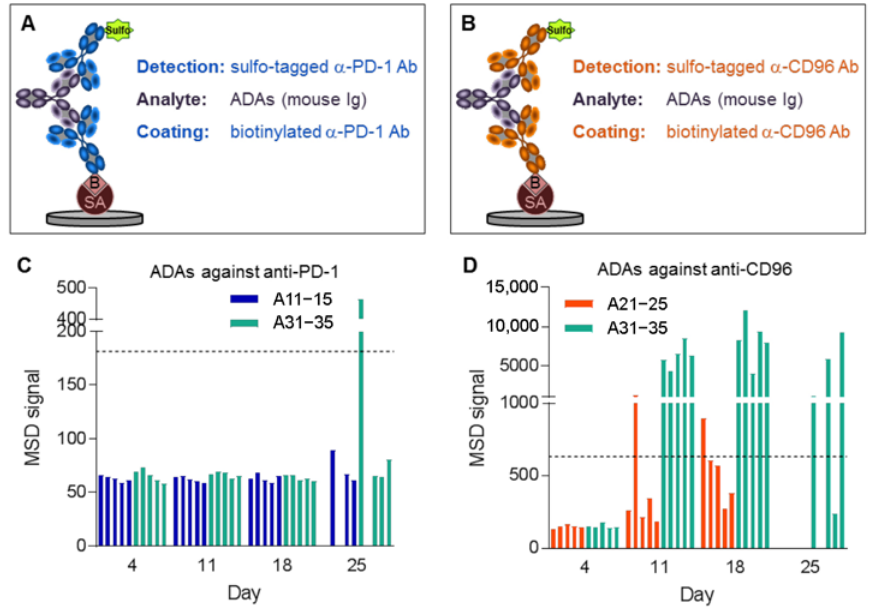
Figure 5. ADAs against anti-CD96 and anti-PD-1. ADA assays on the MSD platform against ( A ) anti-PD-1 and ( B ) anti-CD96 using streptavidin (SA)-coated plates. MSD signal for measurement of ADAs against ( C ) anti-PD-1 and ( D ) anti-CD96. Horizontal lines indicate MSD signals three times above background that are considered positive for ADAs. Plasma samples for animals 11, 13, 21–25 and 32 at day 25 are missing because these animals were sacrificed due to high tumor load.